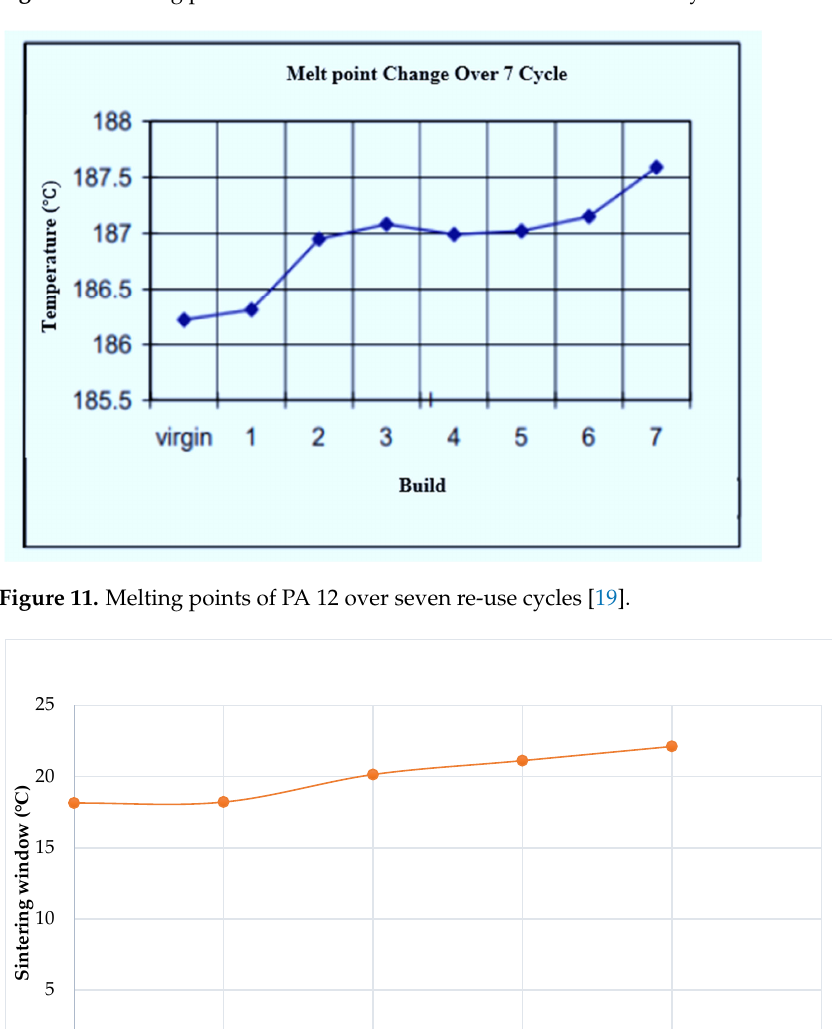
Figure 10. Melting points of Laser PP CP 75 over a number of re ‐ use cycles.